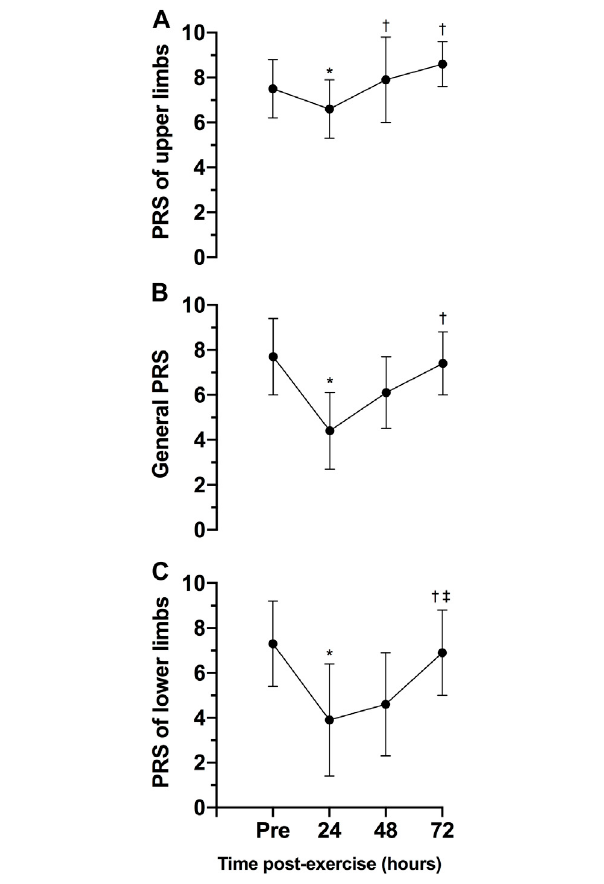
FIGURE5| Variablesareexpressedasmeanandstandarddeviation(±). Perceived recovery scale (PRS) of the upper limbs (A) general (B) and lower limbs (C) duringpre-test, 24,48and72 hposttest.* p ≤ 0.05forpre-exercise; † p ≤ 0.05 for 24-h post-exercise; ‡ p ≤ 0.05 for 48-h post-exercise.